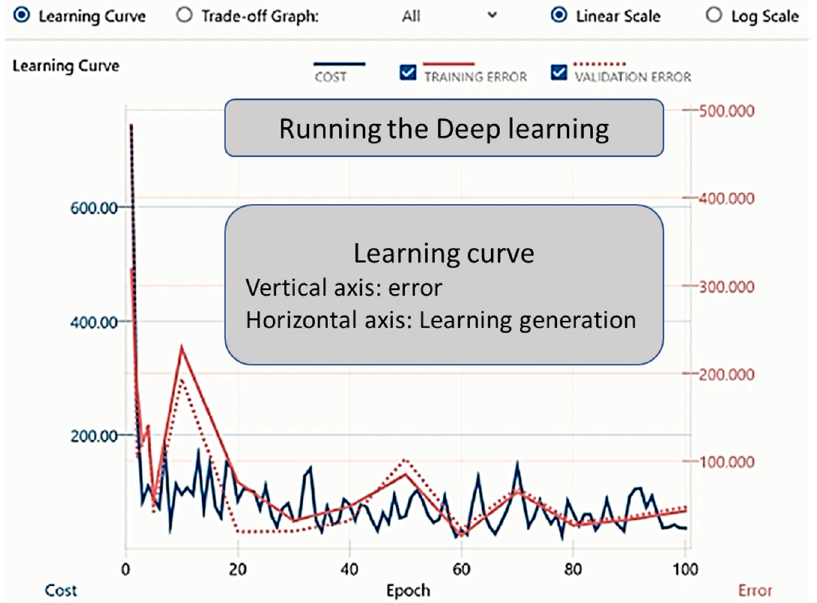
Figure 2. Graphical user interface of the DL process. The figure explains the experimental process with the Neural Network Console. The “Learning Progress” and “Learning Results” screens are shown. Clicking on the learning curve button commences deep learning, and the progress will be shown in the Learning Curve on the graph monitor (the learning result screen). Training ends with the set number of epochs.